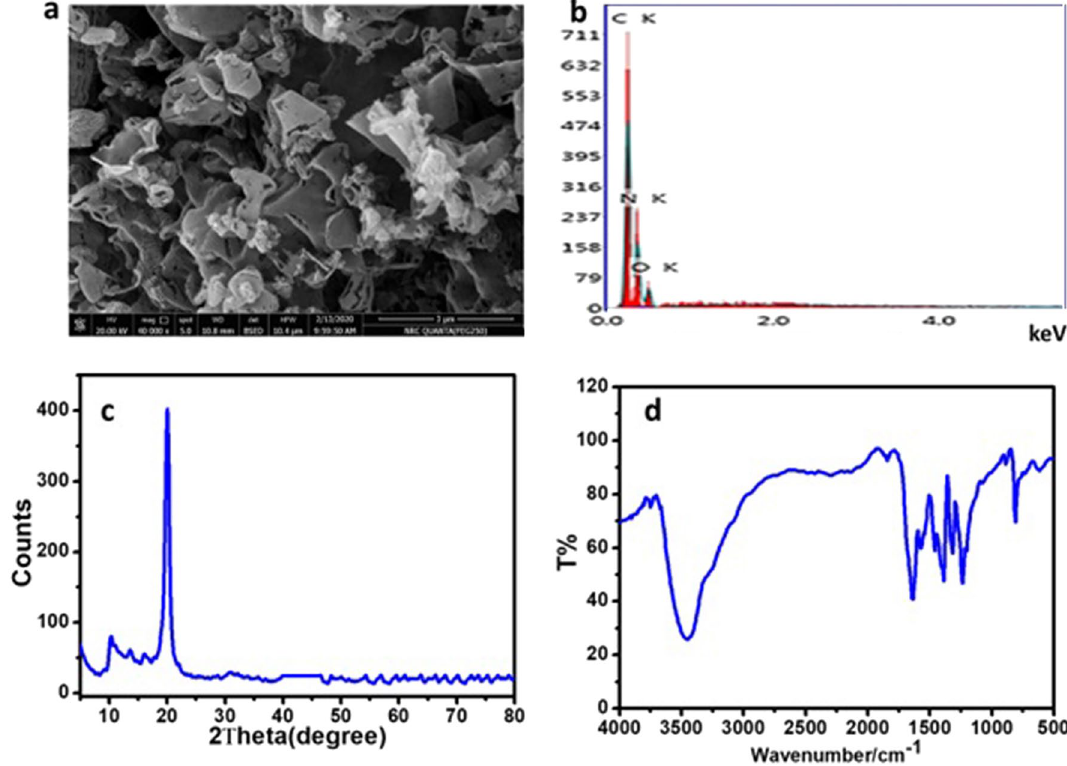
Figure 6. SEM image of the prepared g-C 3 O 4 ( a ), EDS spectrum ( b ), FTIR spectrum ( c ), and XRD patterns ( d ),